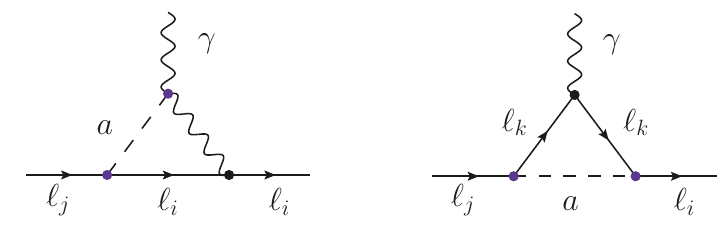
‘ i (cid:13) at linear (left panel) and !